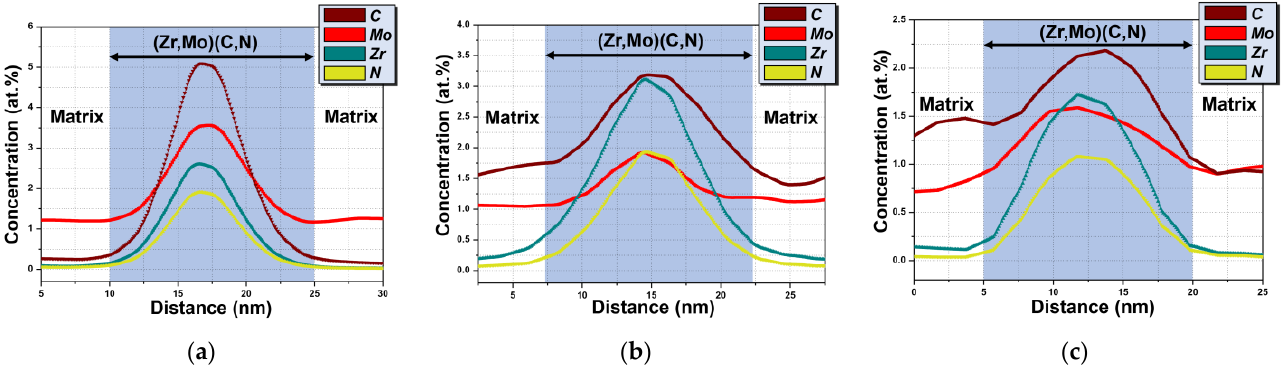
Figure 9. 1D concentration distribution of C, Mo, and Zr atoms corresponding to a single (Zr, Mo) (C, N) particle, indicated by the black arrow at different irradiation dose specimens ( a ) 0 dpa, ( b ) 1.0 dpa, and ( c ) 20.0 dpa, respectively.